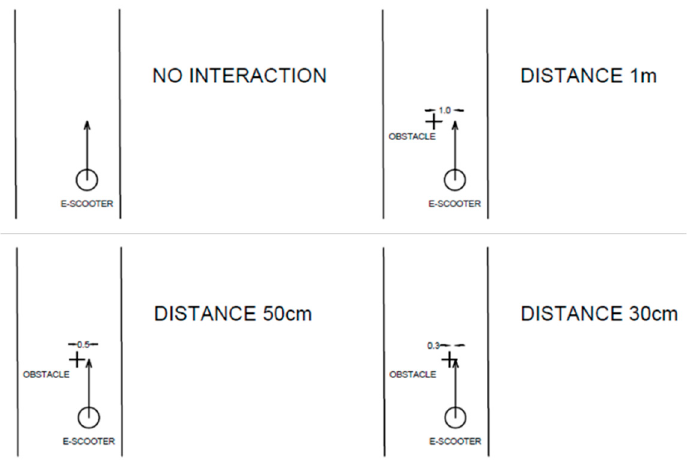
Figure 3. Different types of distances considered.